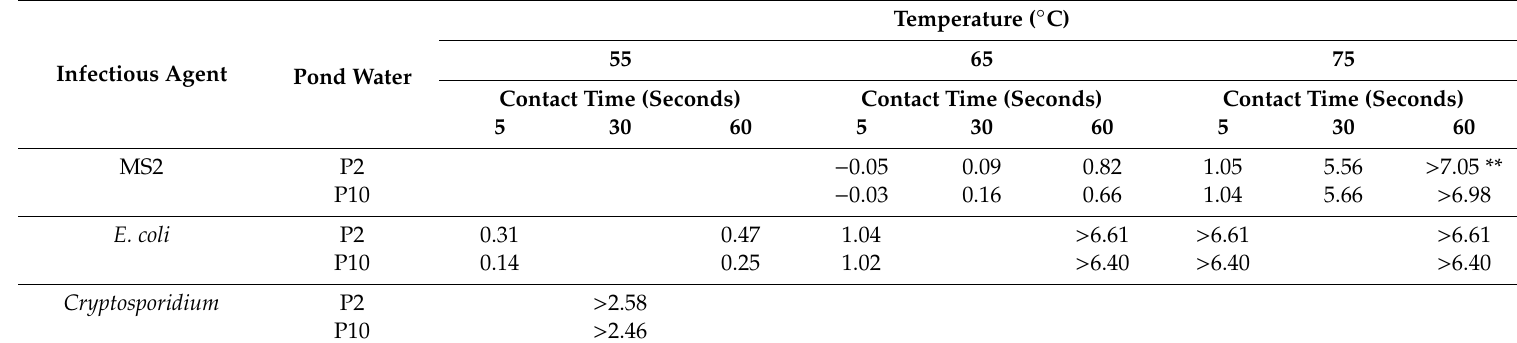
Table 4. E ff ect of WTP pond water on log reduction values for male specific coliphage (MS2), Escherichia coli and Cryptosporidium in laboratory trials at di ff erent temperatures and contact